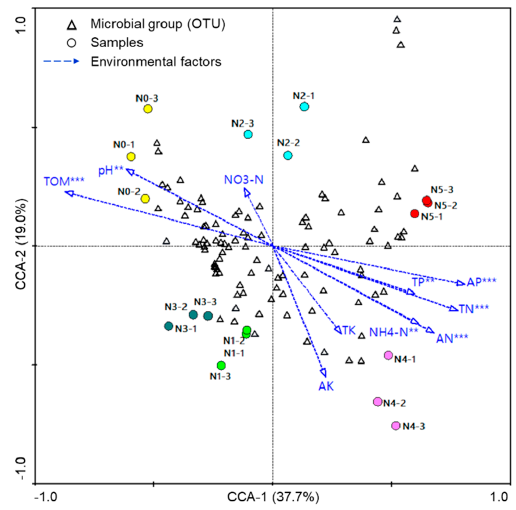
Figure 6. Canonical correspondence analysis (CCA) ordination diagram of bacterial communities associated with environmental variables based on Illumina MiSeq sequencing of the 18 samples in the 6 treatments. ** and *** indicate significant correlations at p < 0.01 and p < 0.001, respectively.